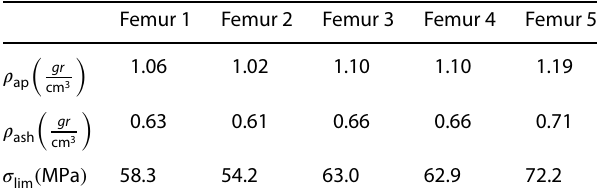
Table 3 Maximum stress values from the average mass